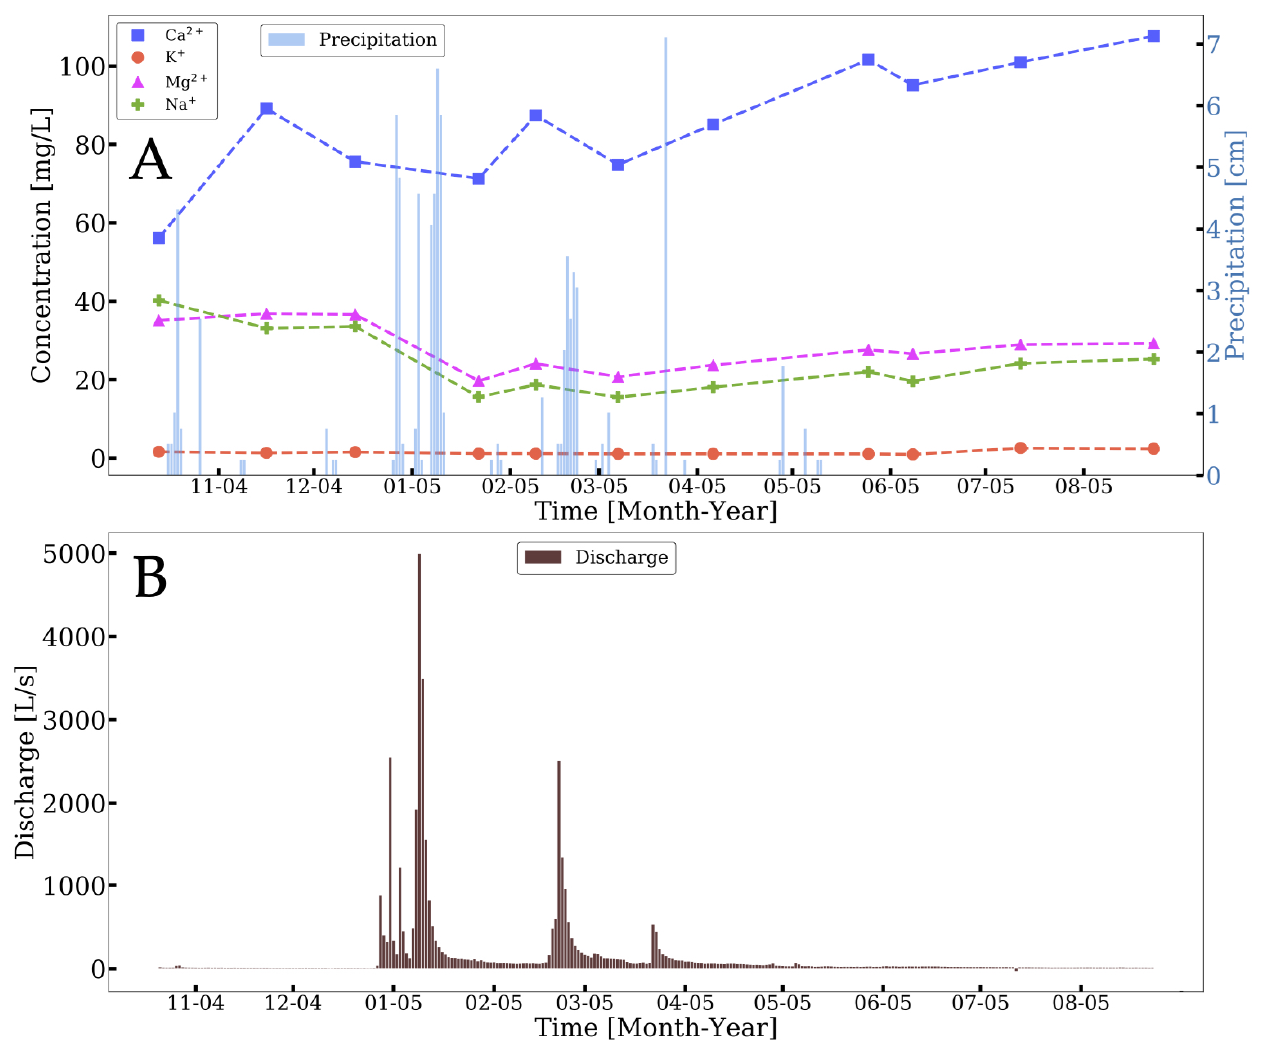
Figure 7. Rattlesnake Creek (unburned comparison site) in 2004–2005: ( A ) major cation concentrations compared with local precipitation [48]; ( B ) daily average discharge from Rattlesnake Creek